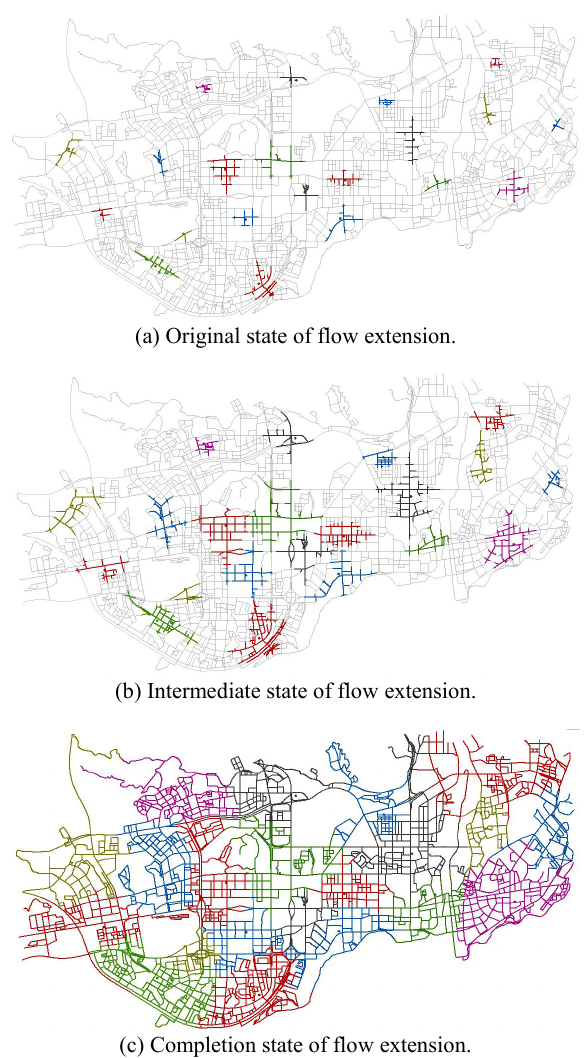
Figure 7. Computing generalized network Voronoi diagram of hotel points in Shenzhen. Table.1 Performance parameter of the algorithm